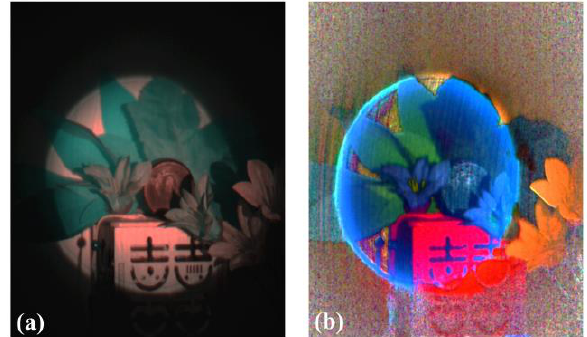
Figure 3. ( a ) The false-color map of the raw active HSI data cube, constructed with RGB channels using 640, 550 and 470 nm, separately. ( b ) The false-color map of the active HSI data cube after radiometric calibration, generated by RGB channels using 675, 606 and 520 nm, separately to show